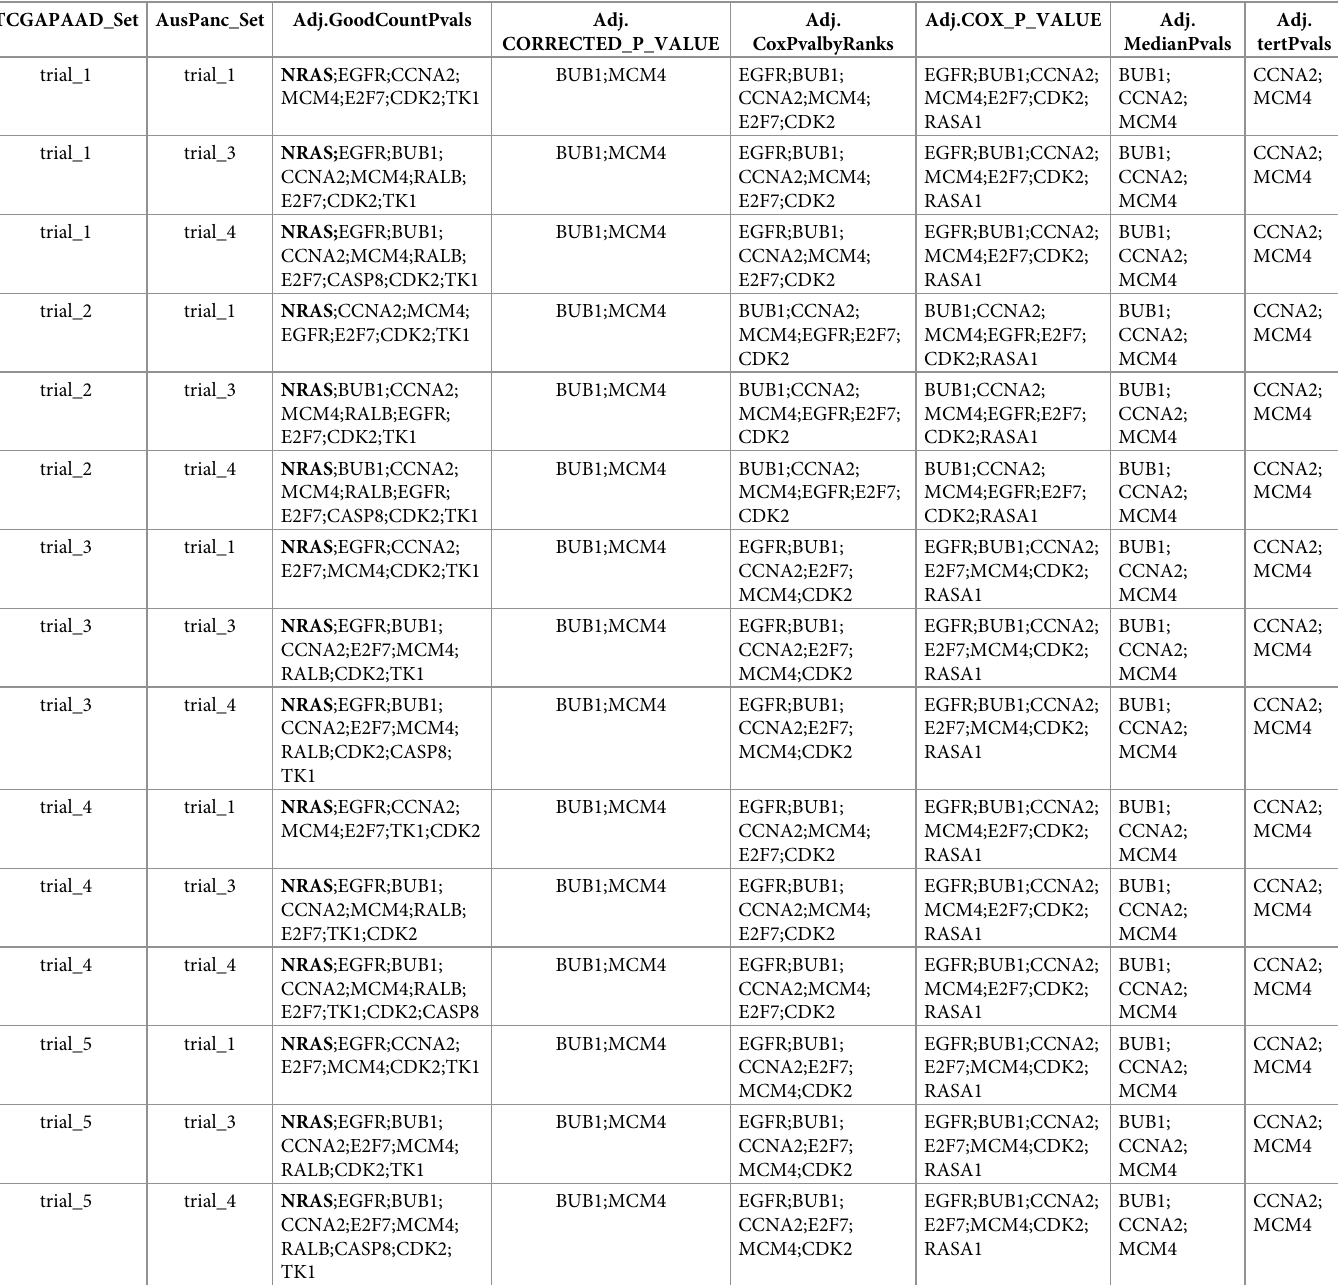
Table 1. Comparison of shared genes identified by selected methods on two independent PAAD